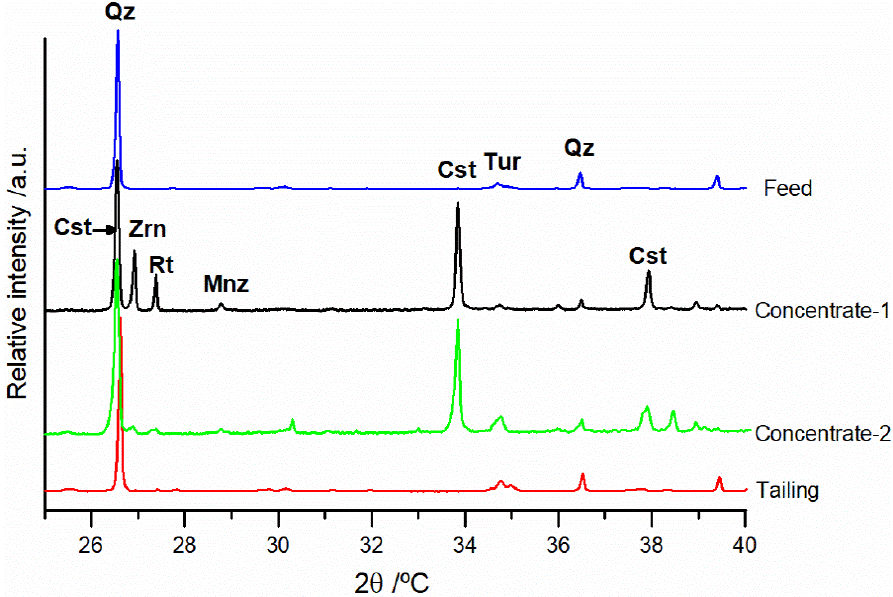
Figure 5. XRD diffractograms of materials from the Catavi processing plant. Qz: quartz; Tur: tourmaline; Cst: cassiterite; Zrn: zircon; Rt: rutile; Mnz: monazite.